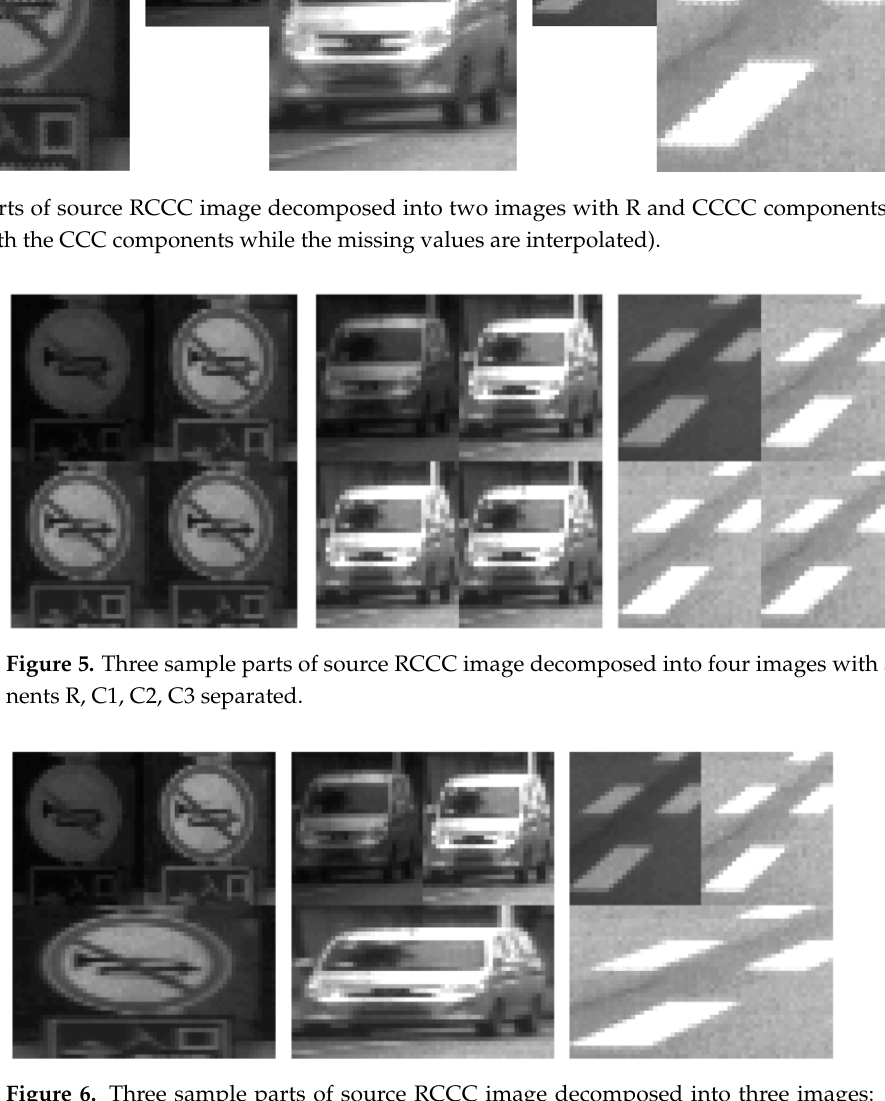
Figure 6. Three sample parts of source RCCC image decomposed into three images: two small images with R and C1 components and a horizontally two times larger image comprising C2 and C3 components.